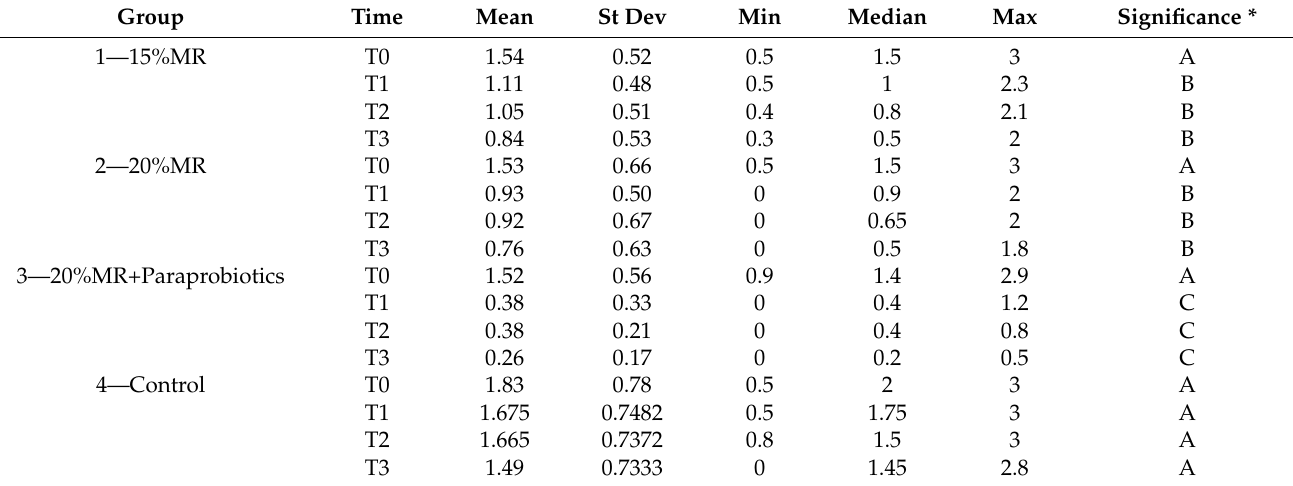
Table 4. Descriptive statistics of full-mouth bleeding score (FMBS).